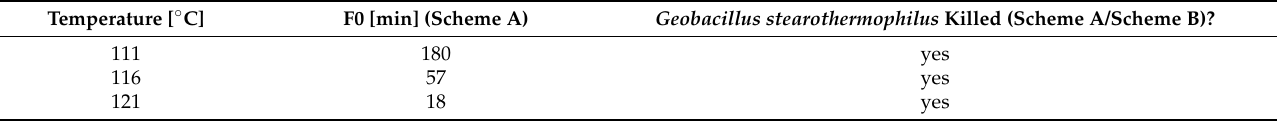
Table 2. Overview of the autoclaving results with regard to the germ Geobacillus stearothermophilus . Temperature [ ◦